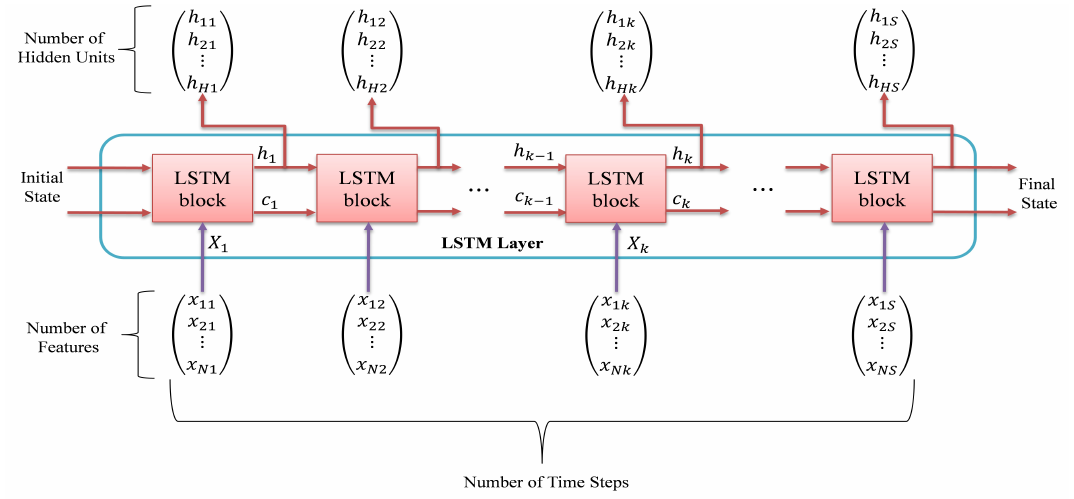
Figure 7. LSTM layered Architecture (source: mathworks/lstm).